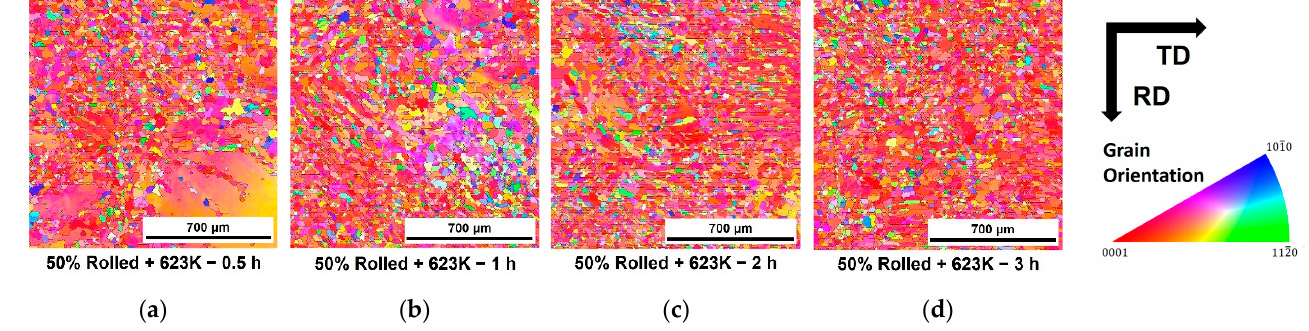
Figure 5. Microstructures of the specimens after rolling with the 50% reduction and annealing at 623 K for ( a ) 0.5, ( b ) 1, ( c ) 2 and ( d ) 3 h.